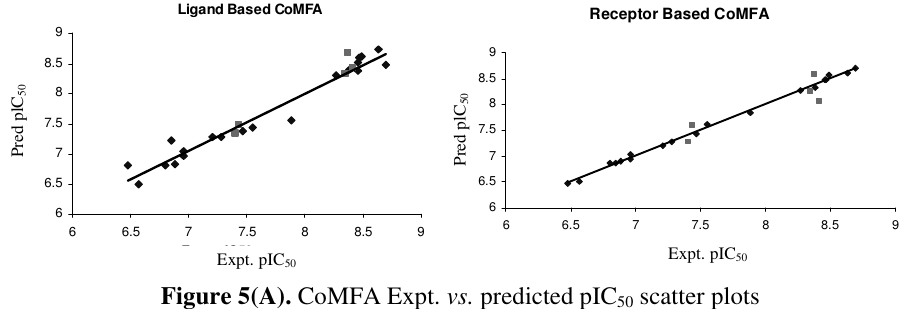
scatter plots 50